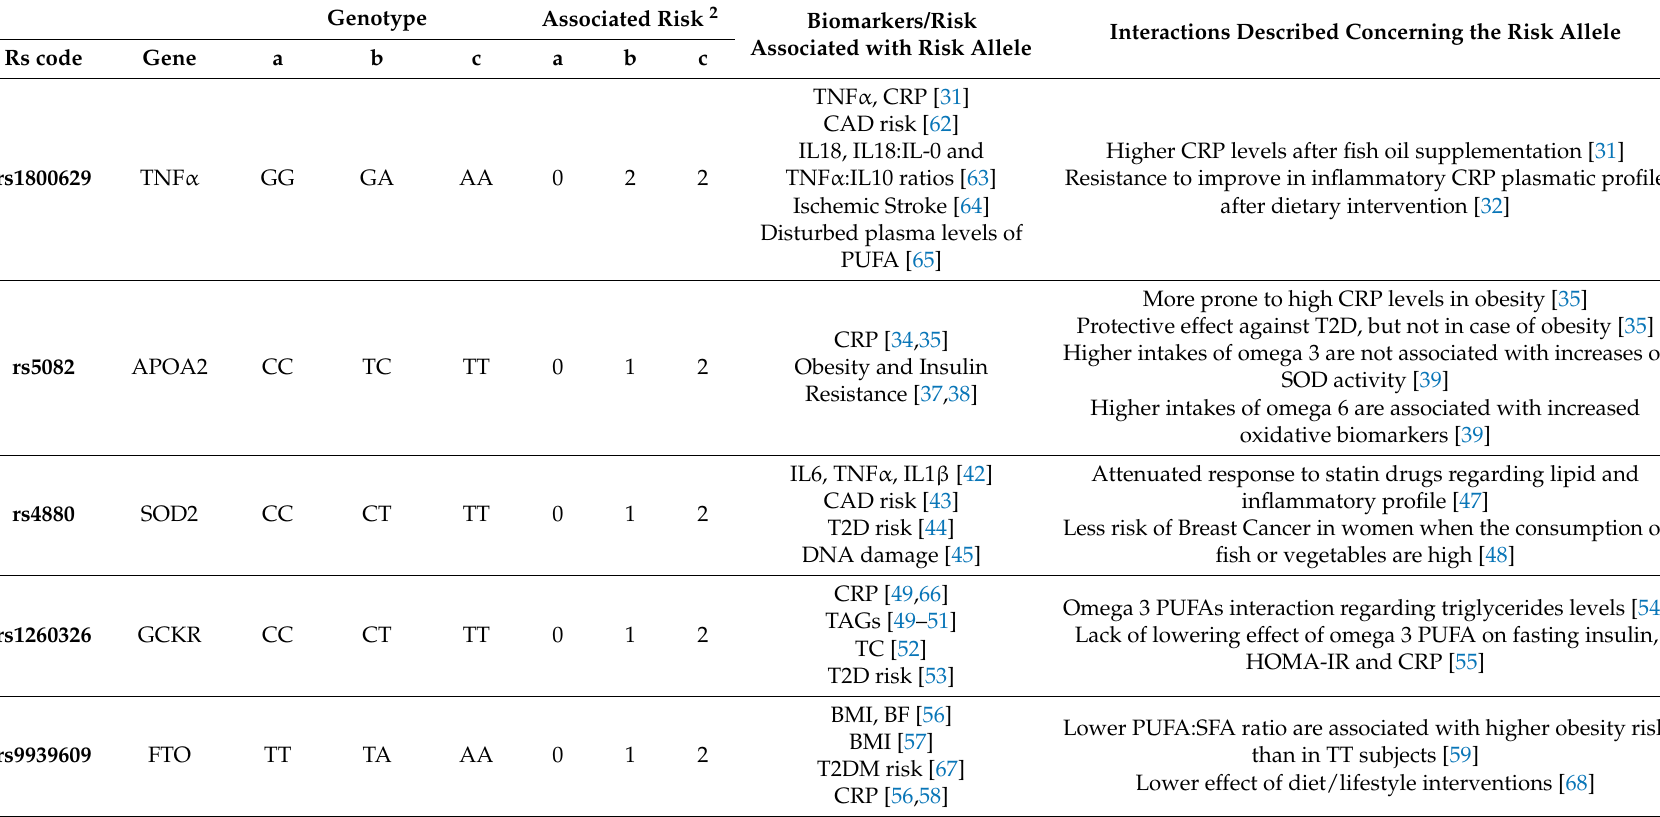
Table 1. Genes and single nucleotide polymorphism (SNP) forming part of the LGI-Ob genetic score 1 .